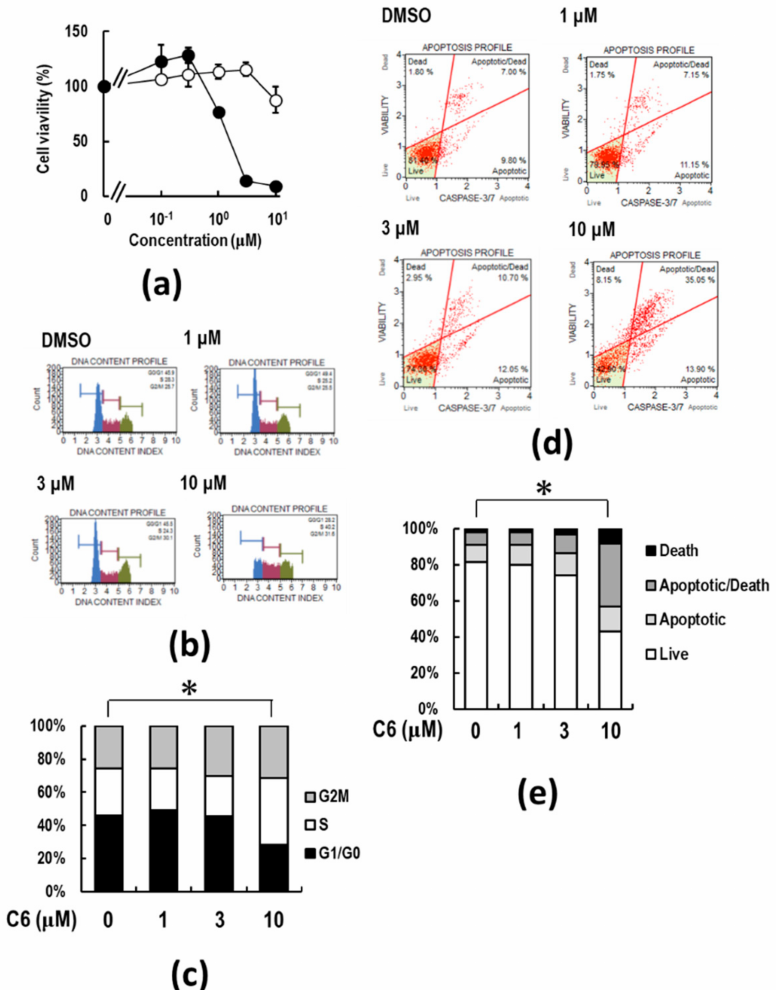
Figure 3. Anti-proliferative activities of C6 and C7 in HCT116 cells. ( a ) WST-8 cell activity assay was performed as described in Section 4. HCT116 cells were treated with 0, 0.01, 0.03, 0.1, 0.3, 1, 3, and 10 µ M C6 or C7 for 72 h. ( b , c ) Cell cycle analysis was performed by flow cytometer. HCT116 cells were treated with 0 (DMSO), 1, 3, and 10 µ M C6 for 48 h. ( d , e ) Caspase-3/7 activity was measured by flow cytometer. HCT116 cells were treated with 0 (DMSO), 1, 3, and 10 µ M C6 for 48 h. Population analyses of apoptotic cells were performed by a flow cytometer. The horizontal and vertical axes indicate the caspase-3/7 activity from the signal of the cleavage of the fluorescent dye-conjugate substrate and cell death from the signal of 7-AAD-positive cells, respectively. * The distributions of population of cell cycle and cell status (caspase-3/7 activation) were compared by χ 2 goodness-of-fit test with a significance level set as α =